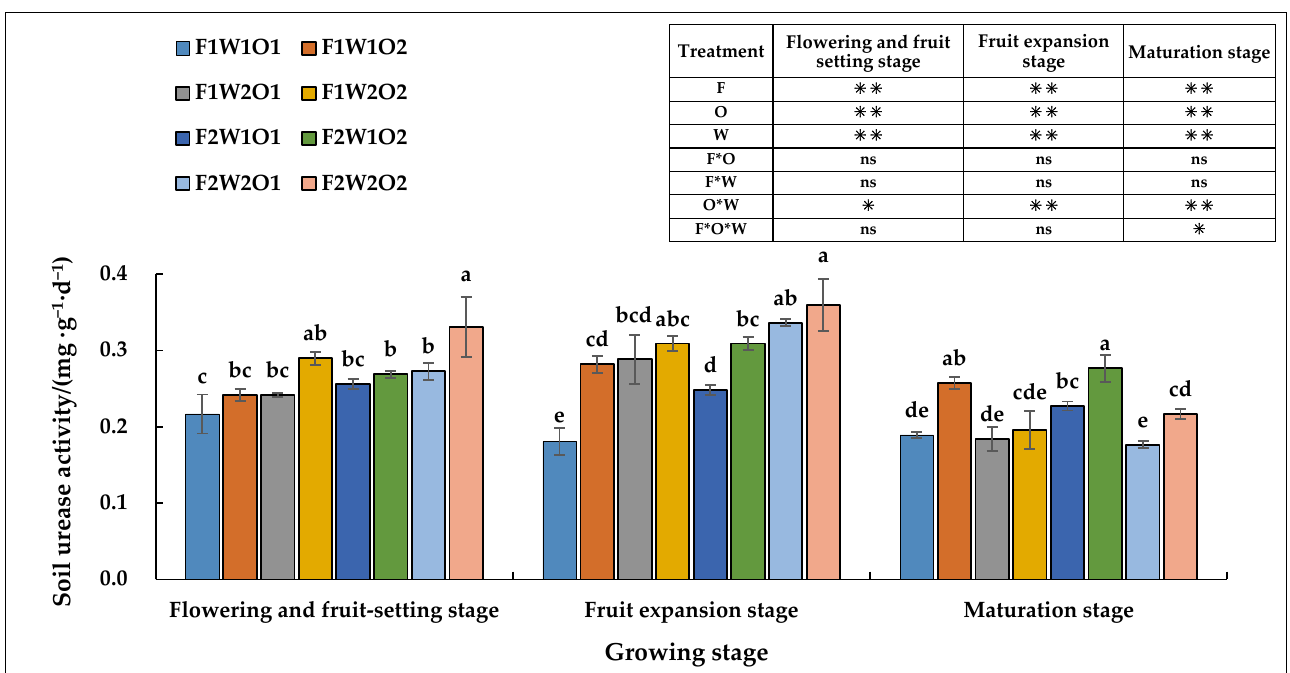
Figure 3. Analysis of variance of soil urease activity in the tomato root zone under different treatments. Note: F represents the fertilizer amount, O represents the oxygen amount, and W represents the irrigation amount. Different letters indicate significant differences at the level of p < 0.05. * p < 0.05. ** p < 0.01. ns, not significant at p < 0.05.